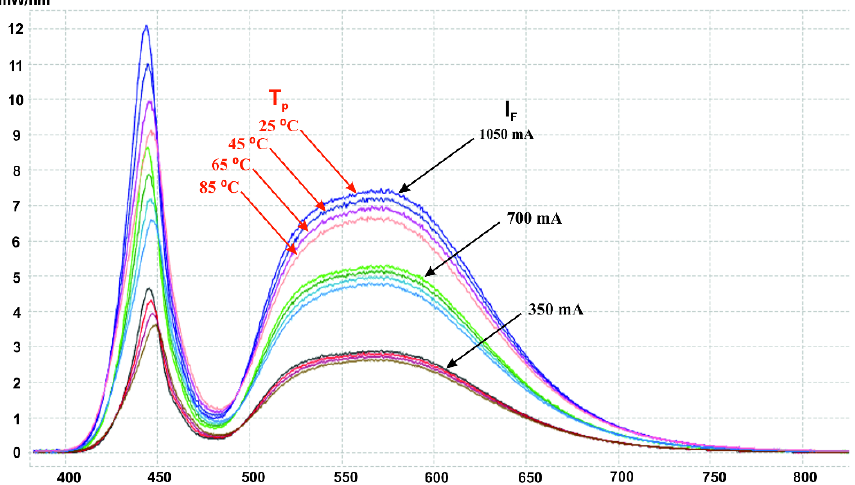
Figure 4. The effect of temperature and forward current on spectral distribution for the studied LED source.